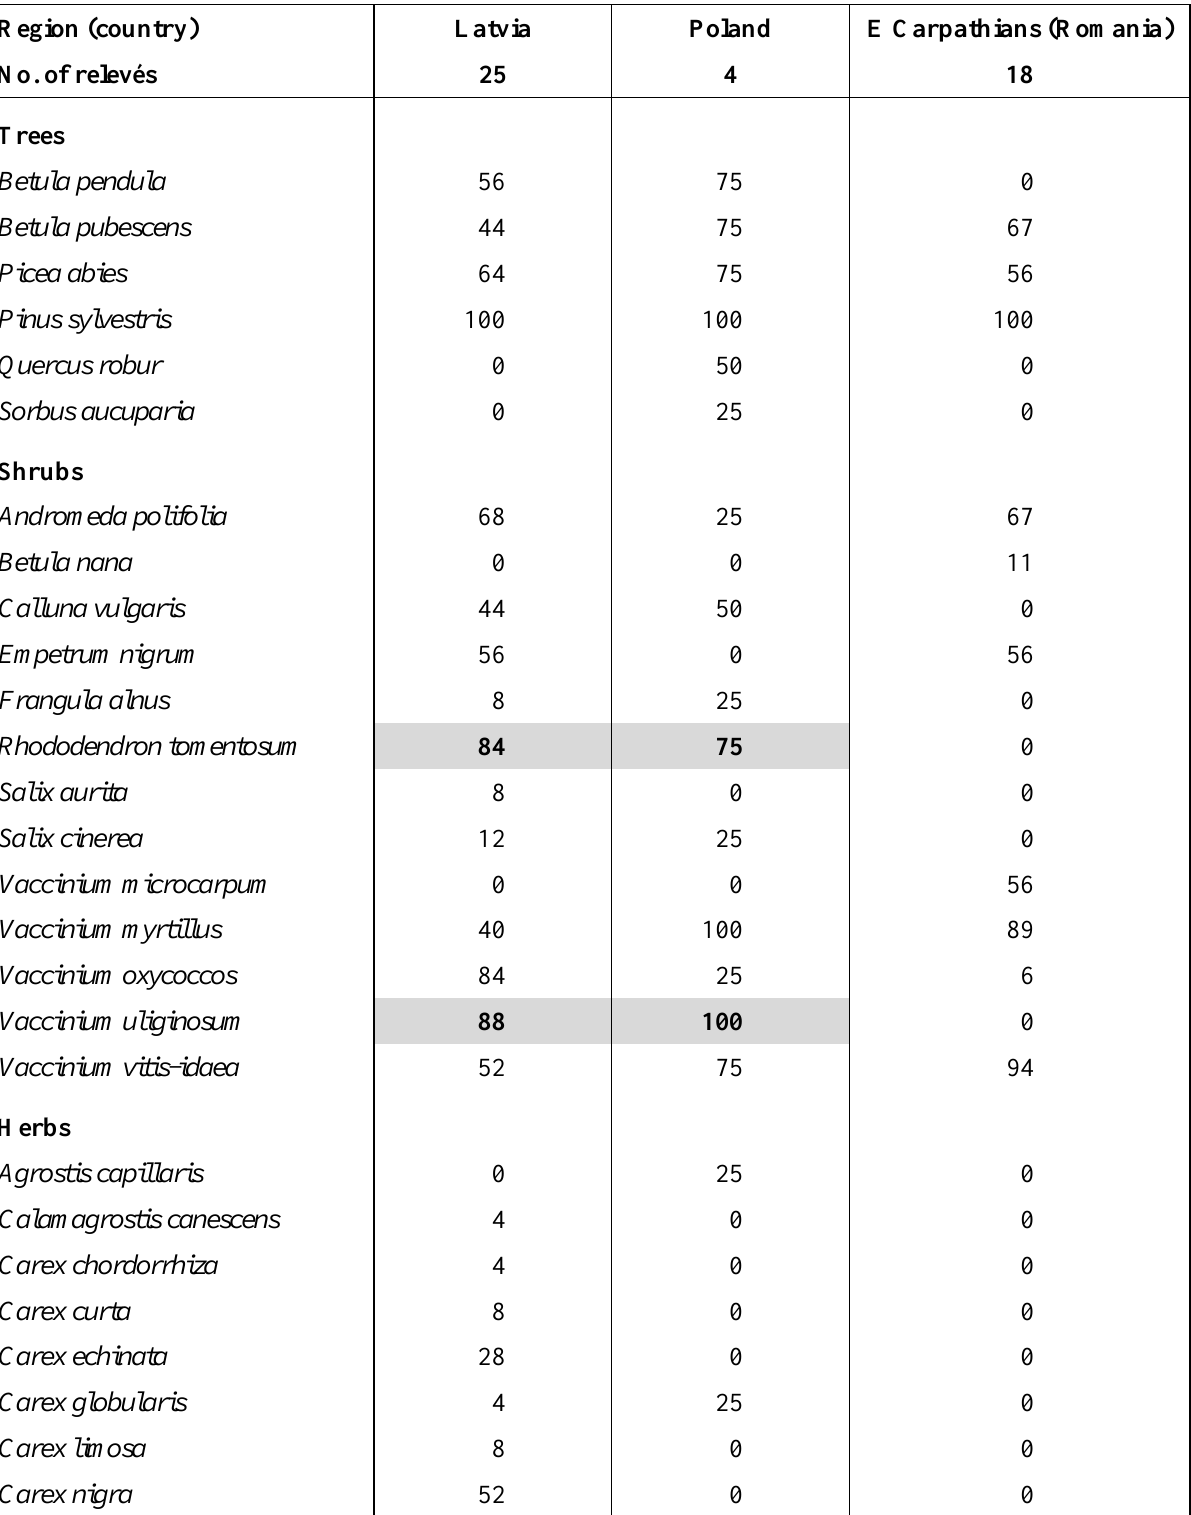
Table A1. Synthetic table displaying the species frequencies (%) of occurrence in the Scots pine woodland communities ( Vaccinio uliginosi-Pinetum sylvestris ) from ombrotrophic bogs of Latvia, Poland and the Eastern Carpathians (Romania). The values in bold (within grey-shaded cells) correspond to regional differential